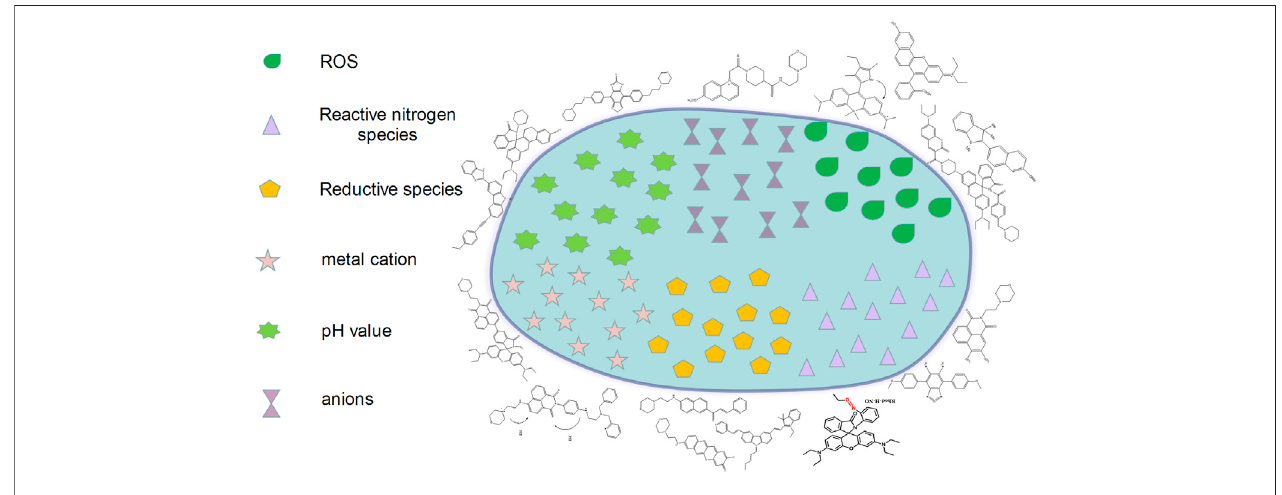
FIGURE 7 | The design strategies of fl uorescence probes targeting lysosomes.